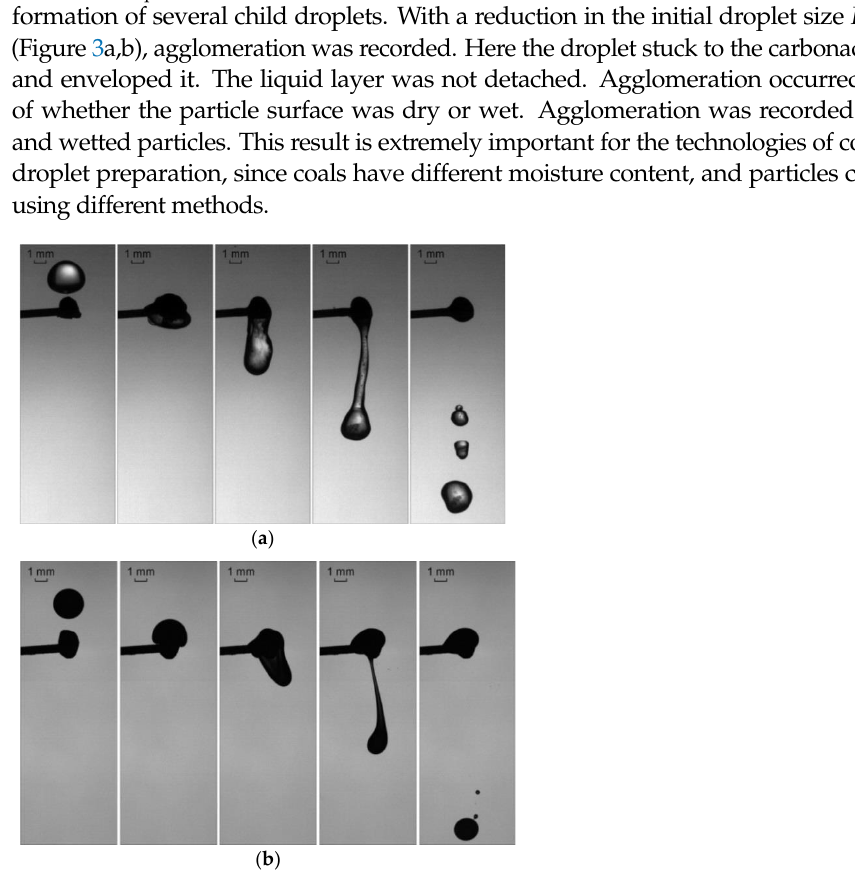
droplet were examined. For that, the radii ( r d ) and number ( N ti ) of all the visible (i.e., droplet was calculated: V 0 = 4·π·( R d13 + R d23 )/3. The total volume of a group of resulting